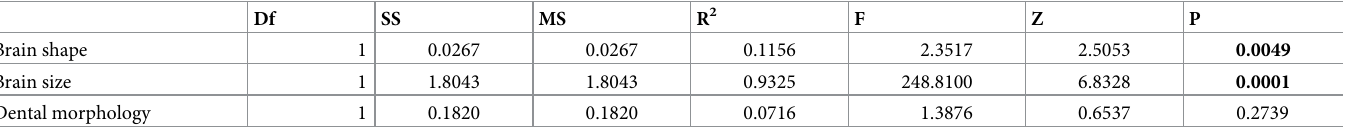
Table 1. Procrustes linear regressions testing the effect of allometry in brain size and shape and dental morphology. Df SS MS R 2 F Z P Brain shape